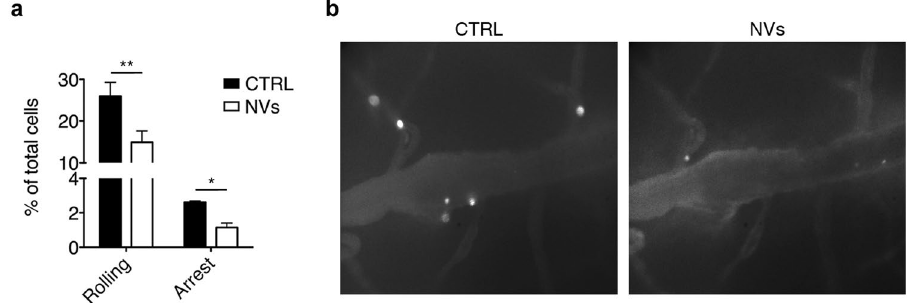
Figure 7. ASC-NVs block activated T cell adhesion in vivo in inflamed spinal cord pial vessels in intravital microscopy experiments. MOG 35–55 -activated splenocytes from 2D2-TCR were treated for 24 hours with PBS (CTRL condition) or 30 ng/ml NVs. Cells were then fluorescently labeled and injected i.v. in EAE recipient mice at disease peak. ( a ) Pre-treatment with ASC-NVs strongly reduced activated T cell adhesion in spinal cord venules, compared to control cells (rolling p = 0.0089; arrest p = 0.0325). Data are from five independent experiments, for a total of 28 venules/condition. ( b ) Representative images of spinal cord pial venules acquired during intravital microscopy experiments. Note the reduced number of adhered NV-treated cells, compared to control cells. Cells are the white spots inside